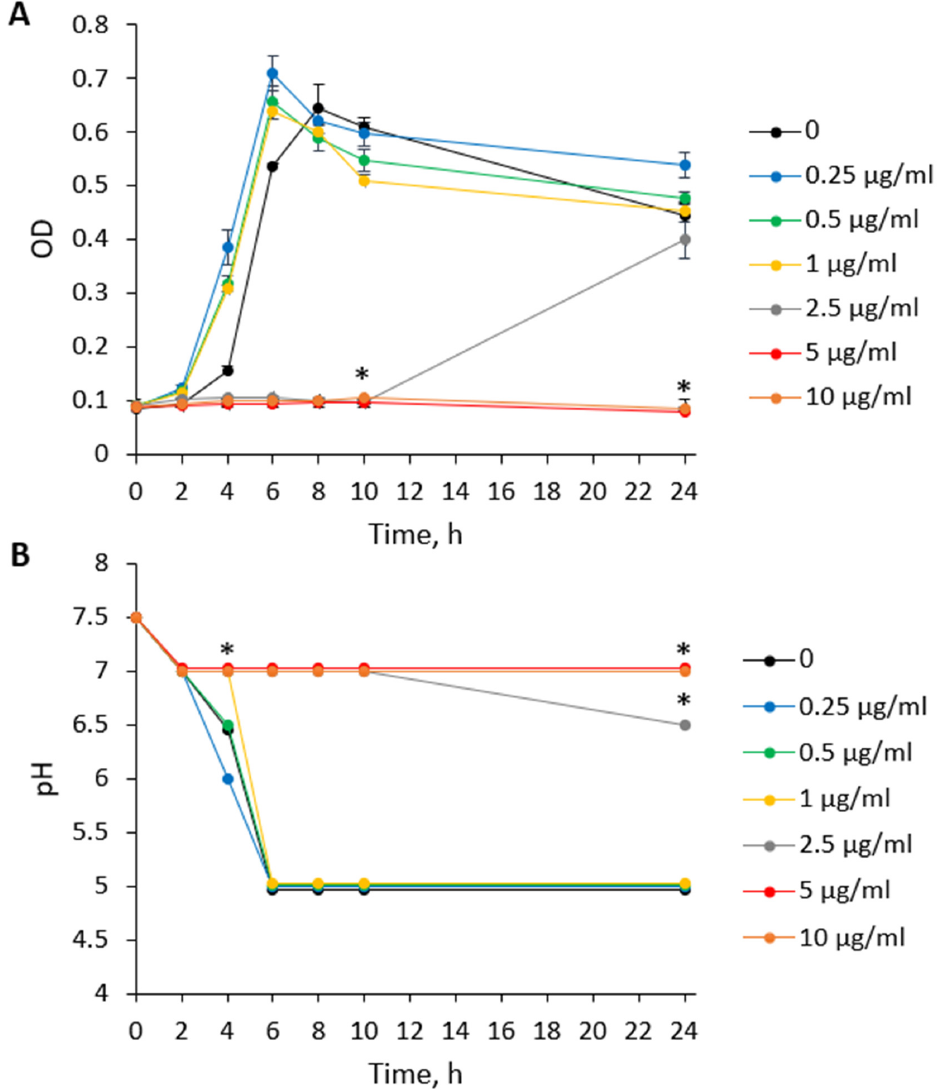
Figure 3. CBD prevents the drop in pH caused by S. mutans . ( A ). The growth of S. mutans of the same samples used in B. The bacterial growth was measured by an OD of 595 nm at different time points for 24 h. ( B ). The pH of the culture medium of planktonic growing S. mutans incubated in BHI with increasing concentrations of CBD. The pH was measured with pH indicator paper strips at different time points for 24 h. The average ± SEM of a representative experiment performed in triplicates is presented. * p < 0.05 in comparison to the control.